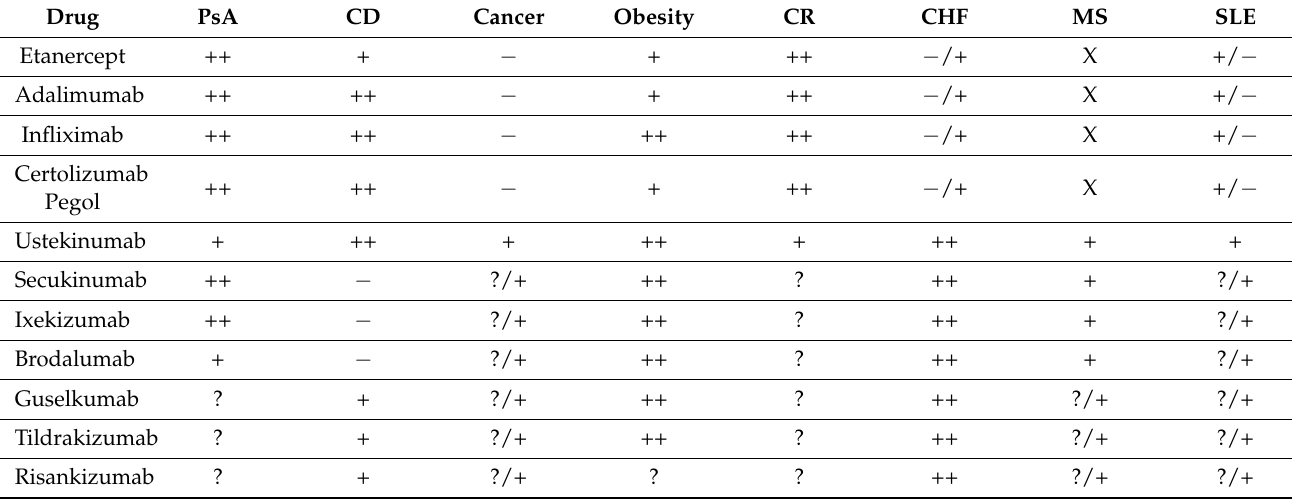
Table 1. Preferred biologic drugs according to specific systemic comorbidities (modified from Kaushik et al. [115]). Drug PsA CD Cancer Obesity CR CHF